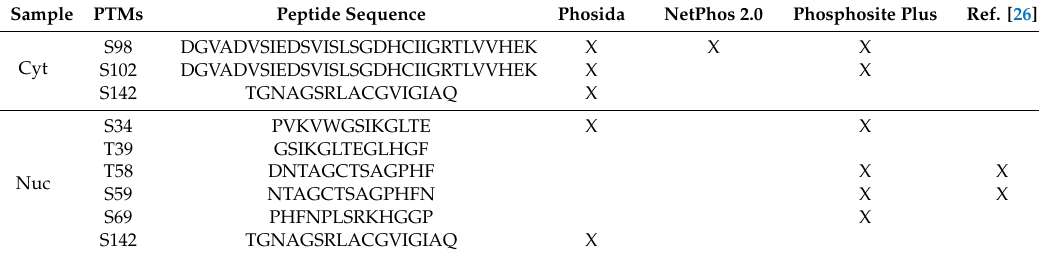
Table 1. List of phosphorylated peptides in cytoplasmic and nuclear compartment identified by MS / MS analysis. The Table reports only the sites with the highest X Correlation value (Xcorr) in Sequest (1.5), the rank value of 1 and the best fragmentation pattern, selected manually after visual inspection of the MS / MS spectra. Three di ff erent tools for phosphorylation site prediction where applied: NetPhos 2.0 Server, Phosphosite plus and Phosida. Samples were analyzed by MS / MS before and after